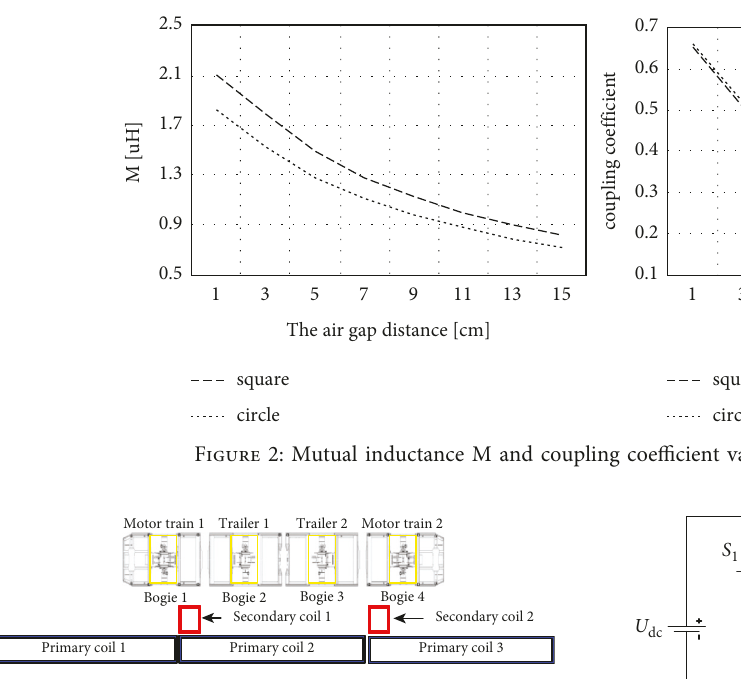
Figure 3: Configuration of couping coils.